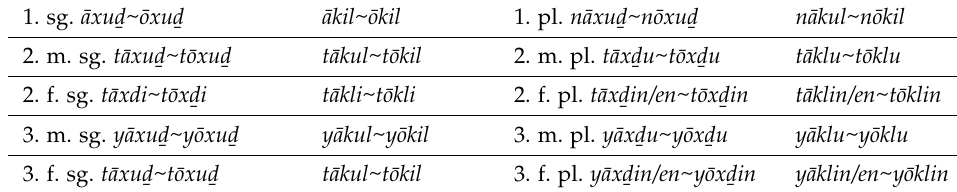
Table 6. Inflexion of